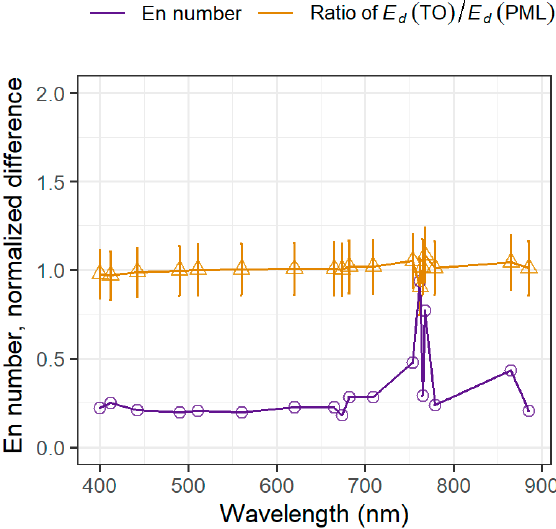
Figure 8. Comparison between TO and PML 𝐸 (cid:2914) (mW·m -2 ·µm -1 ) and respective uncertainties over all OLCI’s band. The comparison in each band separately can be found in Figure A2 for clear conditions and in Figure A3 for all conditions.